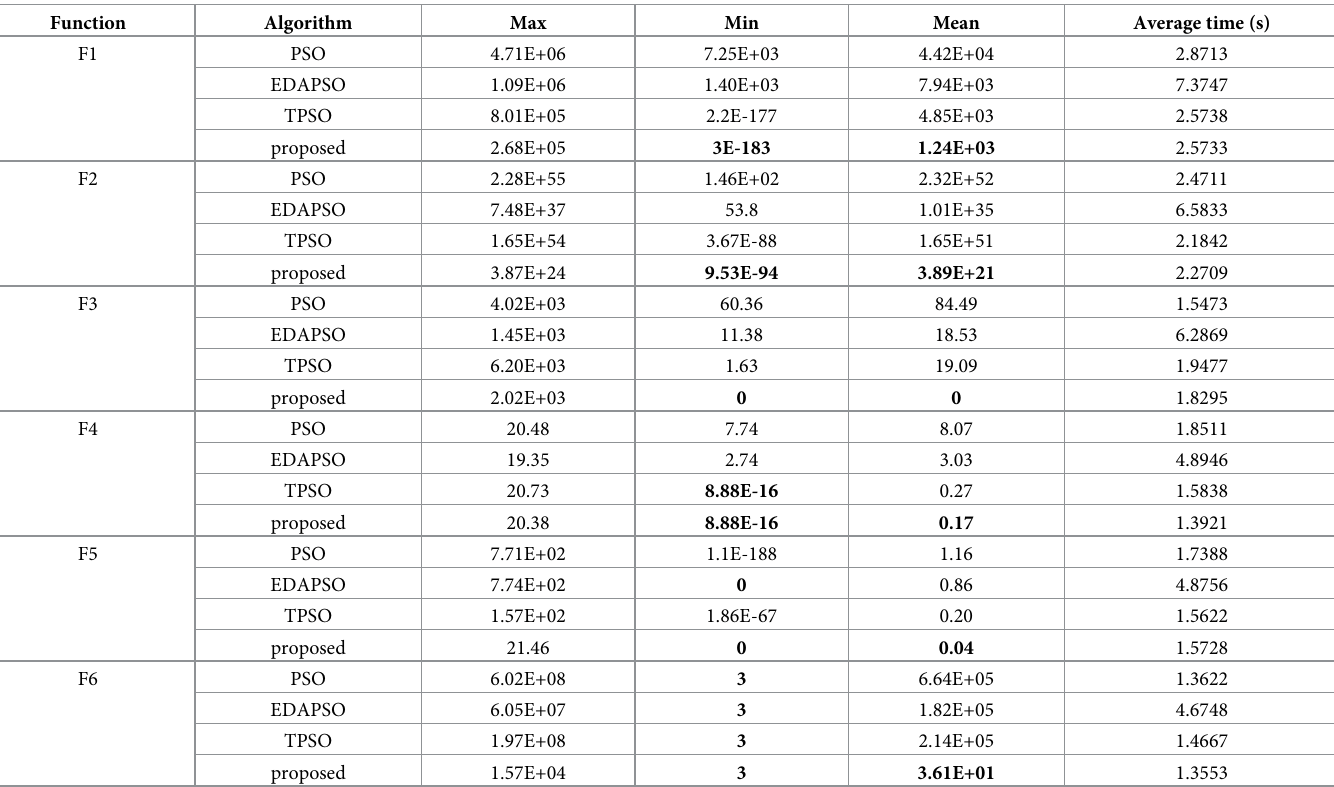
times. By comparing the data in Table 2, the improved PSO algorithm has obvious advantages over the other three PSO, EDAPSO, and TPSO. Considering that the local optimal value is added to the algorithm in this paper and comparing the data in the table, the algorithm in this paper can converge to the global optimal value, especially in F3, F5, and F6, after the Table 2. Function test